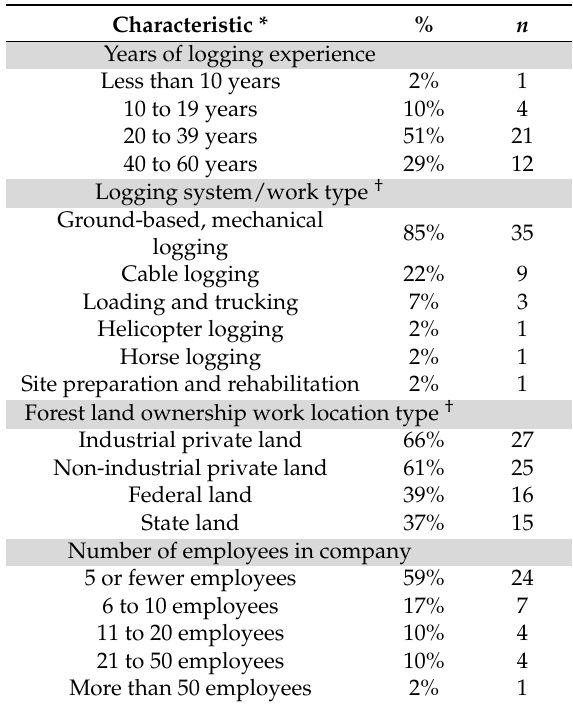
Table 2. Interview participant characteristics ( n =